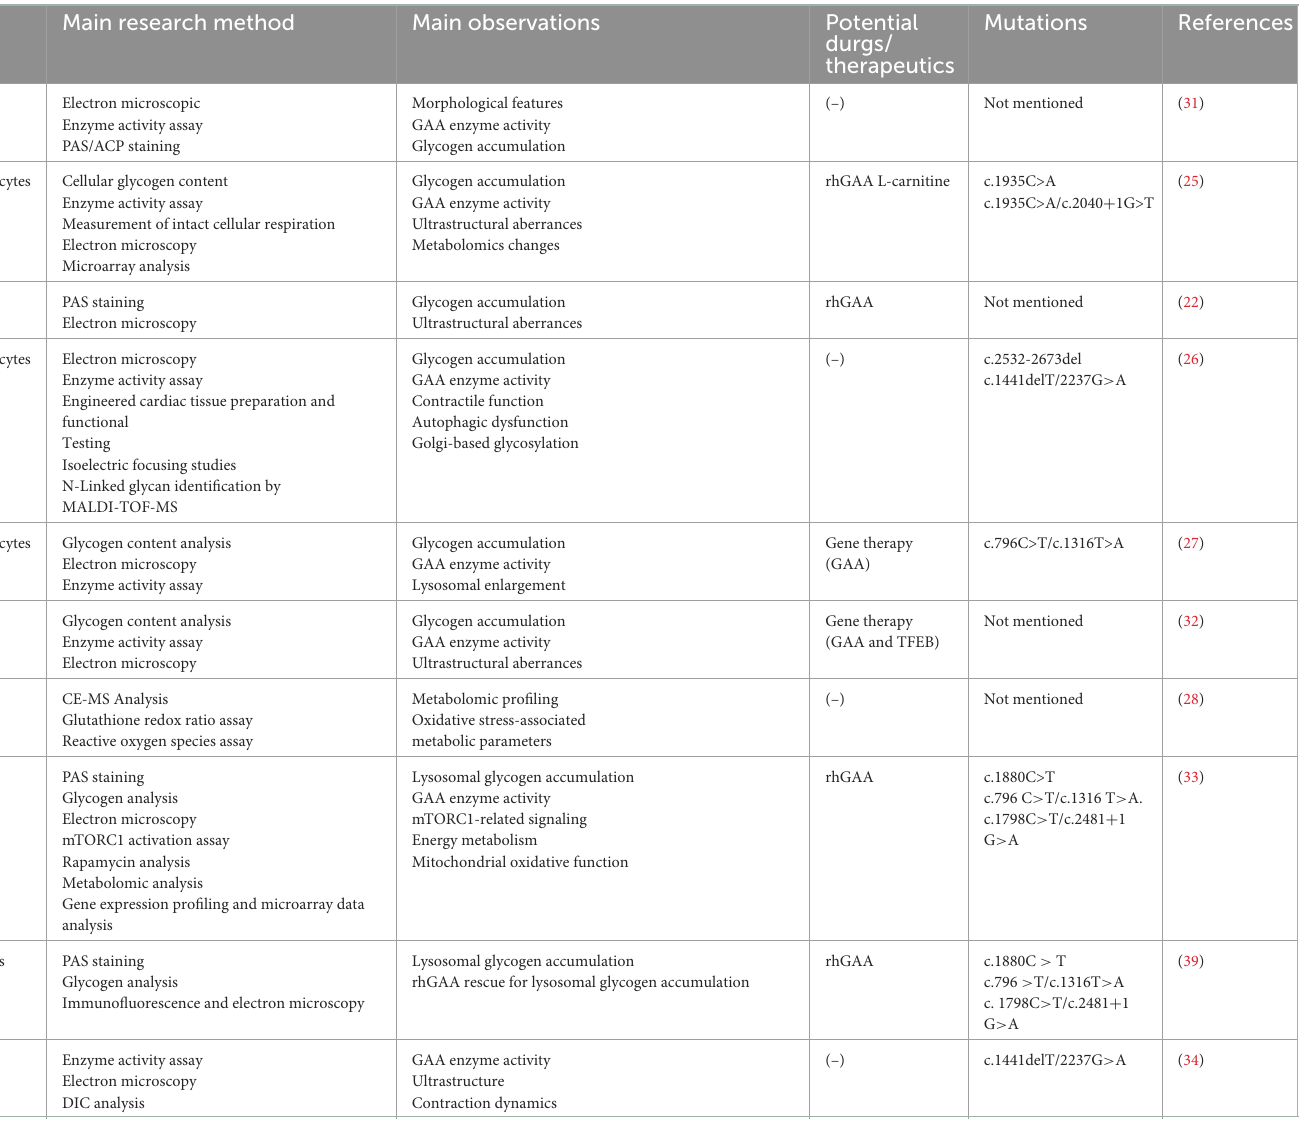
TABLE 1 Characteristics of Pompe disease iPSC